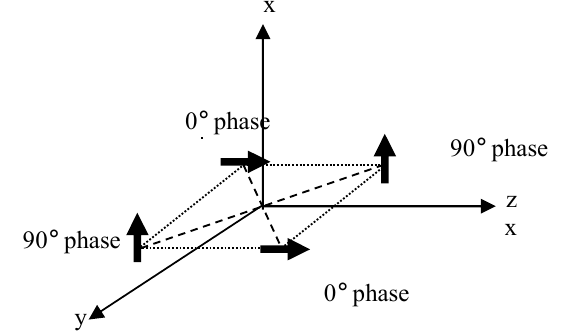
Fig. 10. The equivalent four infinitesimal dipole element